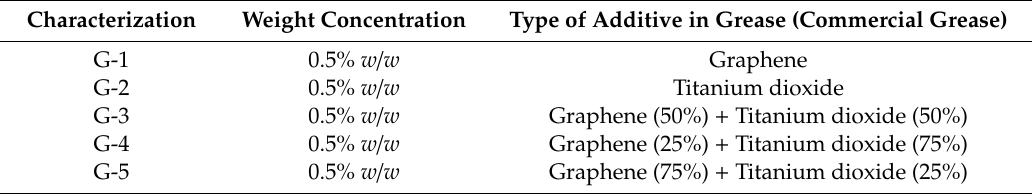
Table 2. Sample characterization of semi-liquid lubricants (grease nano